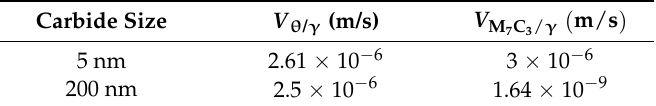
Table 3. Velocity of θ / γ and M 7 C 3 / γ for fine (5 nm) and coarse (200 nm) carbides at the beginning of austenite nucleation.